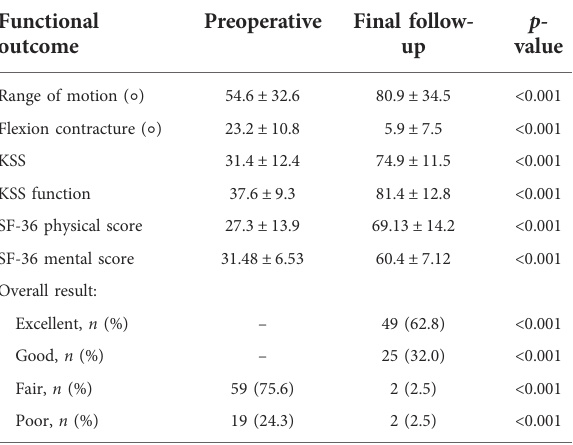
TABLE 3 Clinical outcomes between the preoperative stage and fi nal follow-up.